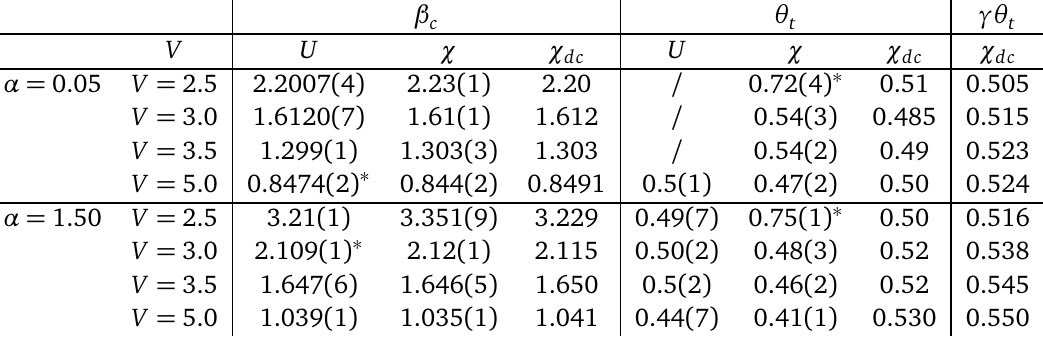
Table 2: Summary of the computed estimates for β finite-temperature transitions at our investigated values of α and V . Our results are categorized according to the methodology employed to derive them: namely, FSS of the Binder cumulant crossings ( U ), FSS of the magnetic susceptibility peak position ( χ ), and data collapse of the susceptibility ( χ ( ∗ ) did not converge with respect to the choice of minimum size to be included in the fitting